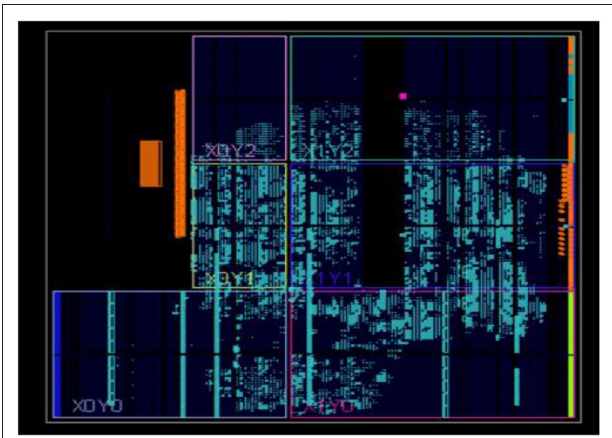
FIGURE 11 | Physical layout for the proposed system.